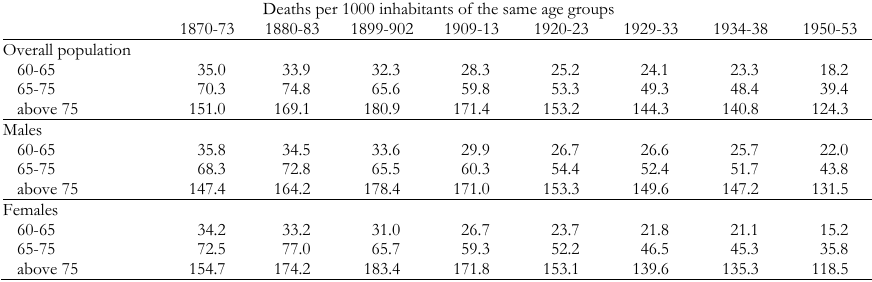
Old age specific mortality rates in Italy from 1870-73 to 1950-53 Deaths per 1000 inhabitants of the same age groups